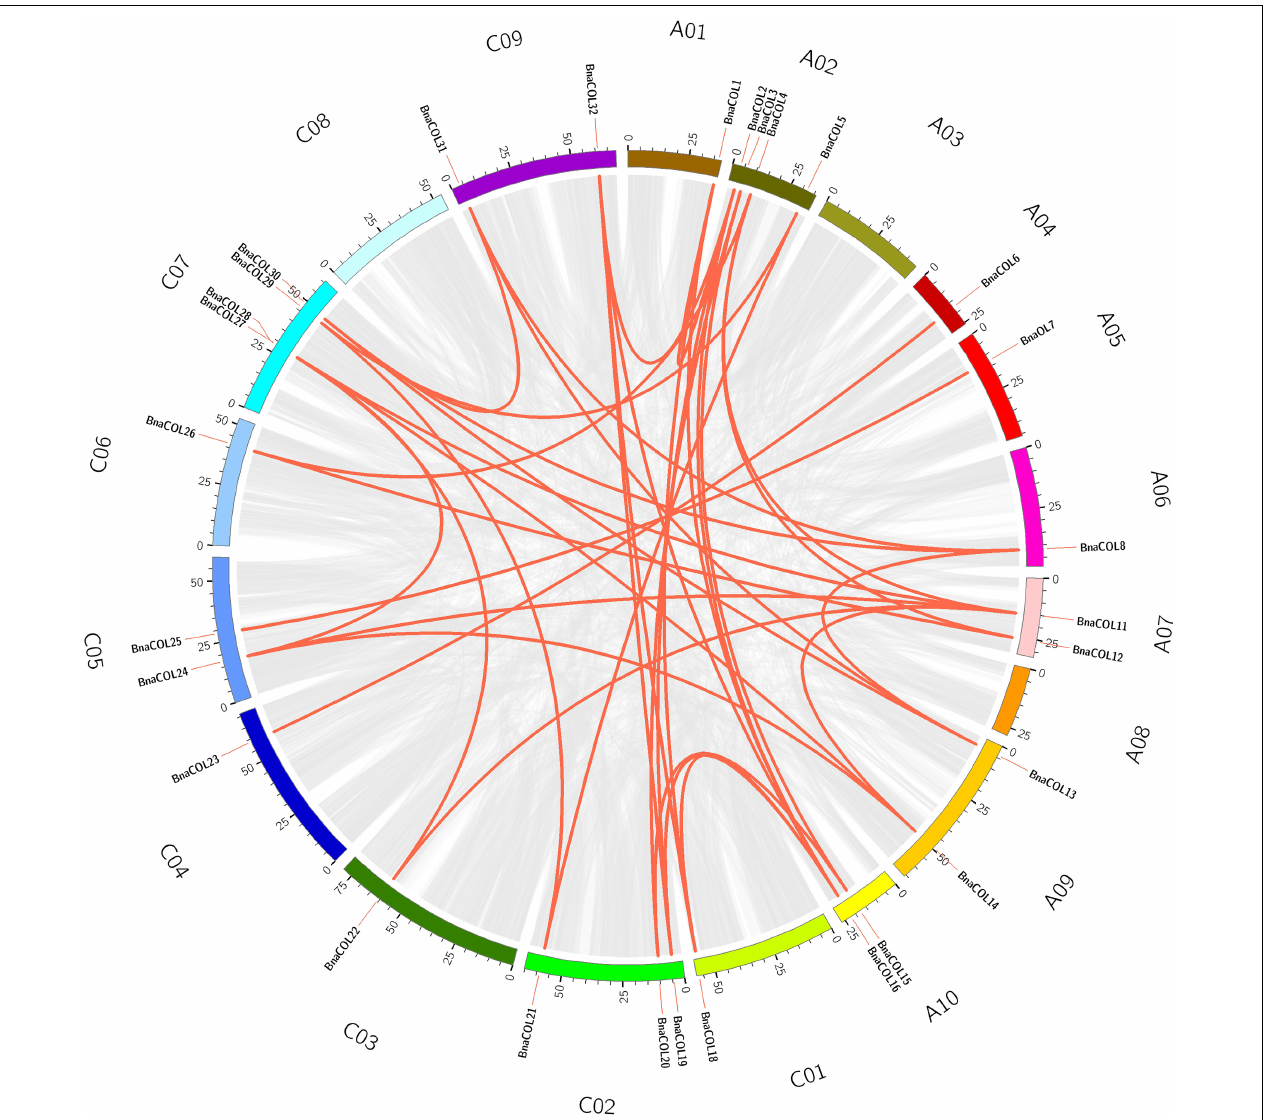
FIGURE 4 | Collinearity analysis of the AC subgenome of COL genes in B. napus. Among them, the gray line represents the replication event of all genes in B. napus and the red line represents tandem repeat events within the BnaCOL genes.